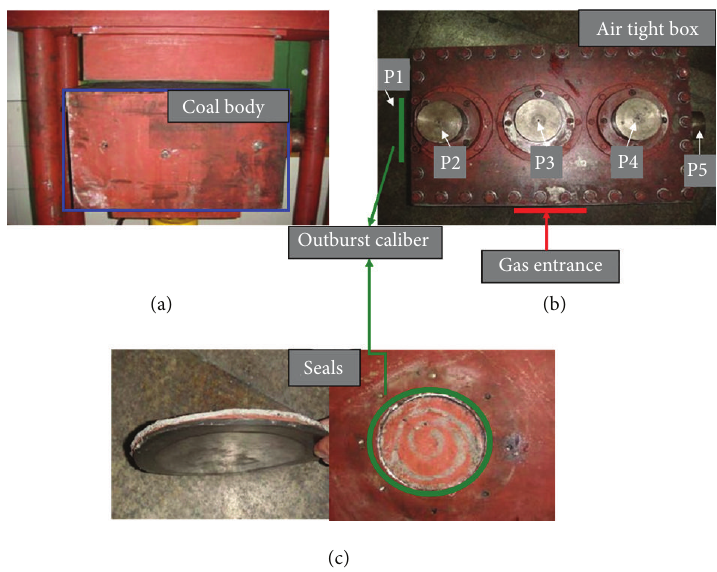
Figure 2: Key components. (a) Compression molded, (b) air tight box, and (c) seals.